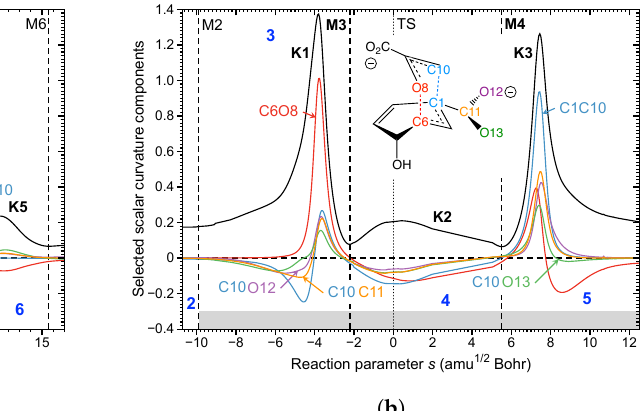
Figure 10. Scalar curvature as a function of the reaction path parameter s (solid black line) for the chorismate rearrangements R1 (gas phase reaction), Figure 10 a and R5 (reaction in BsCM with an extended QM part), Figure 10 b . The decomposition of the scalar curvature into the most important components is given in color. The borders of the reaction phases are indicated by vertical dashed lines at curvature minima M1, M2, M3, etc. Curvature maxima are indicated by K1, K2, K3, etc. The TS at s = 0 amu 1/2 Bohr is also indicated by a vertical dotted line. The reaction phases are denoted in blue print and the chemical phases are highlighted with a gray bar. (Reprinted with permission from [118]; copyright 2020 from Taylor and